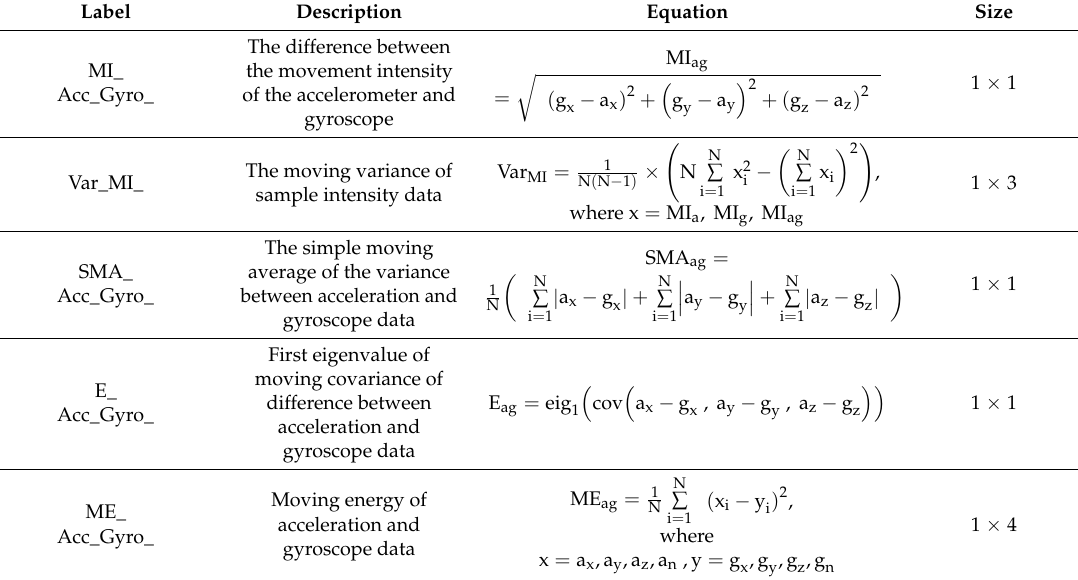
Table 3. The list of features that are extracted from both accelerometer and gyroscope samples